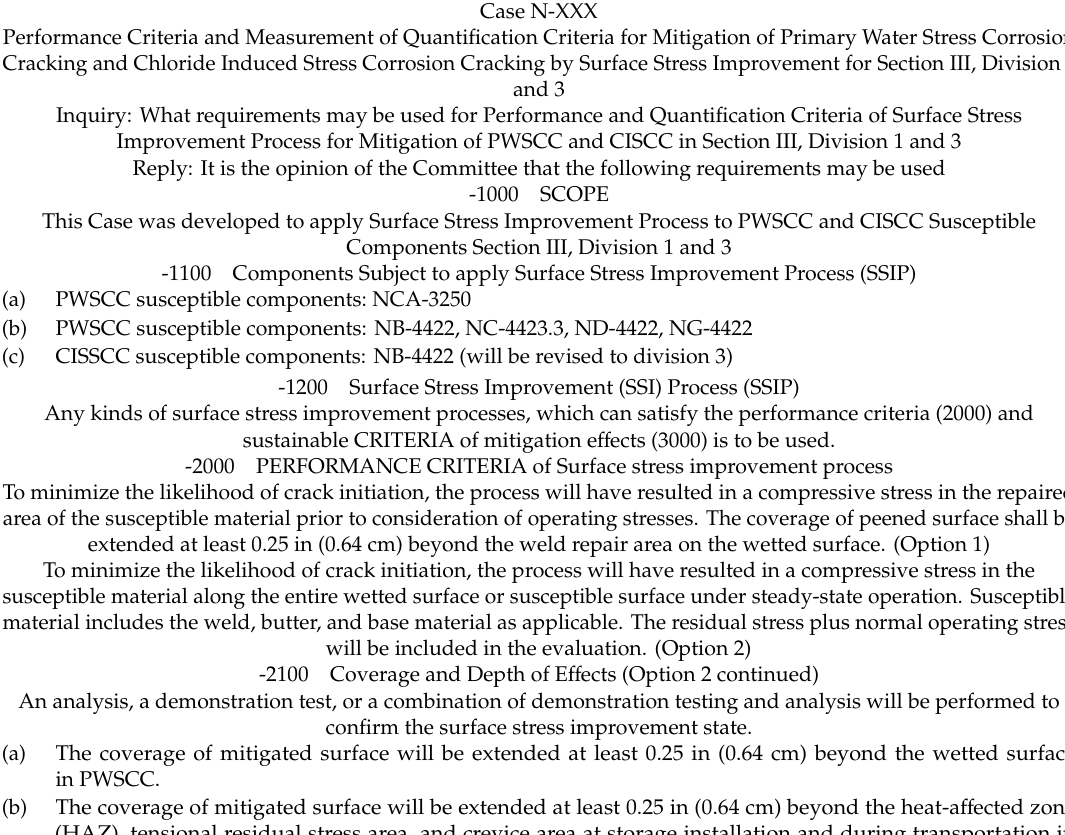
Table 6. Initial draft of the Code Case for the iterative review and consensus